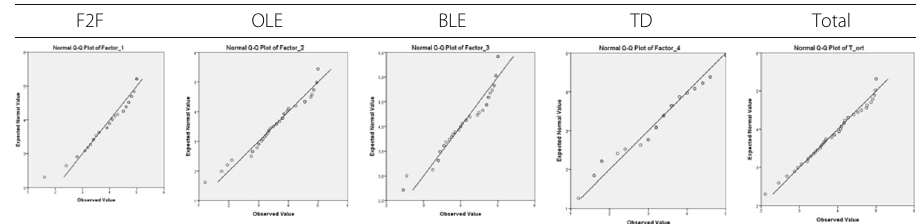
Table 2 Normality tests of sub-factors and total ( Q-Q plot